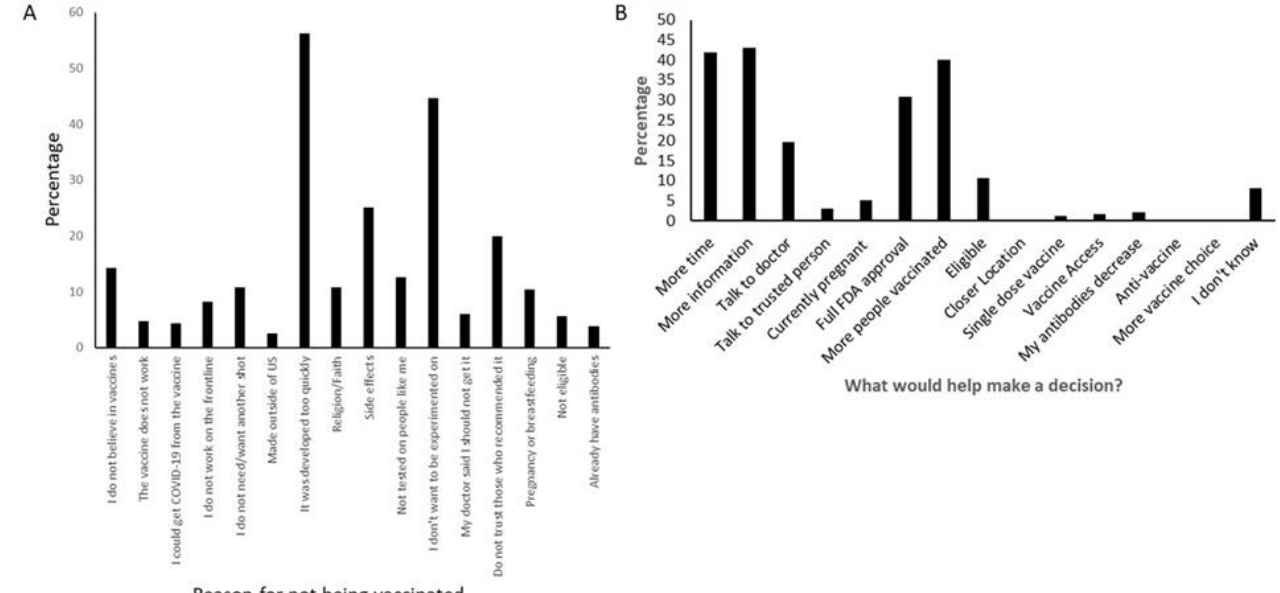
Figure 1. Reasons for vaccine attitudes and behaviors . ( A ). Unvaccinated respondents who indi- cated that they would not be vaccinated in the next three months (refusers) were asked why ( n = 231). ( B ). Those HCW who did not receive the first dose of the vaccine but indicated they were unsure if they would or not (hesitant) were asked what would help them to make a decision ( n = 490).